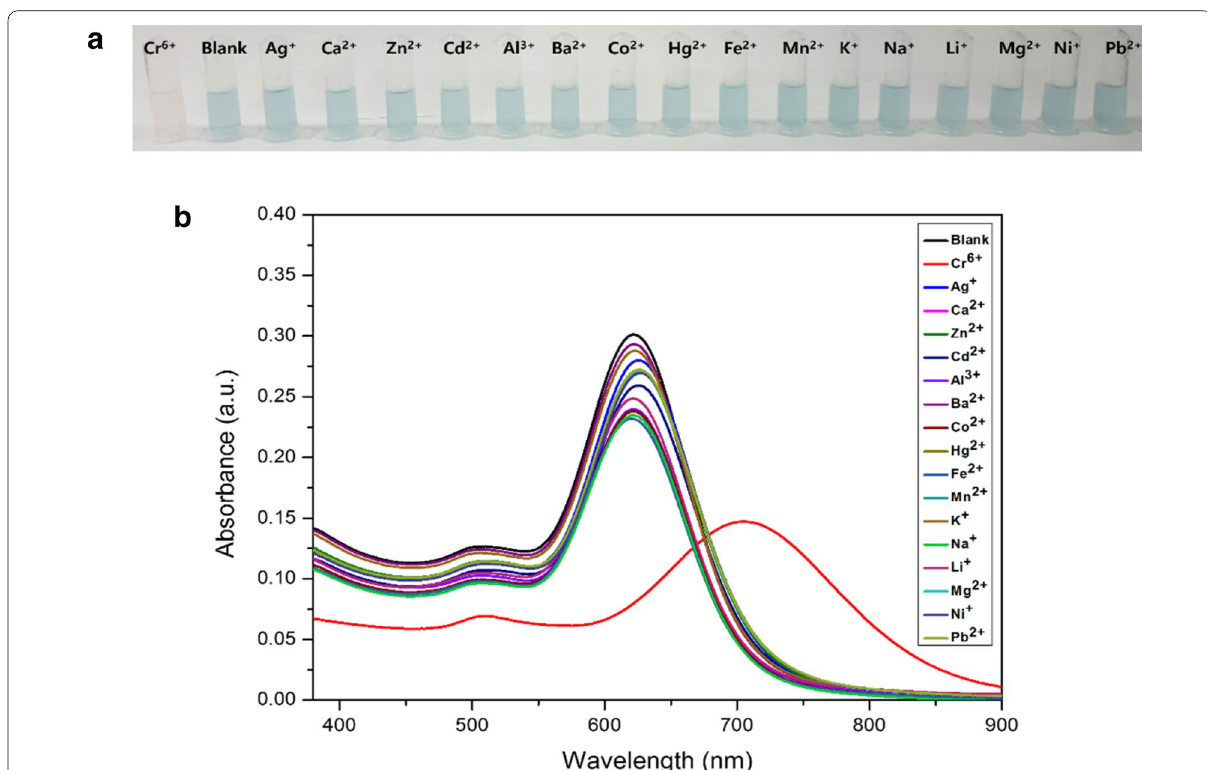
Fig. 7 Selectivity of the AuNR@Ag sensing system. a Photographic images and b the UV–vis spectra of AuNR@Ag based detection systems with various metal ions. (The concentration of Ag + , Ca 2 + , Zn 2 + , Cd 2 + , Al 3 + , Ba 2 + , Co 2 + , Hg 2 + , Fe 2 + , Mn 2 + , K + , Na + , Li + , Mg 2 + , Ni + , or Pb 2 + was 110 − 4 M and the concentration of Cr(VI) was 110 − 6 M)